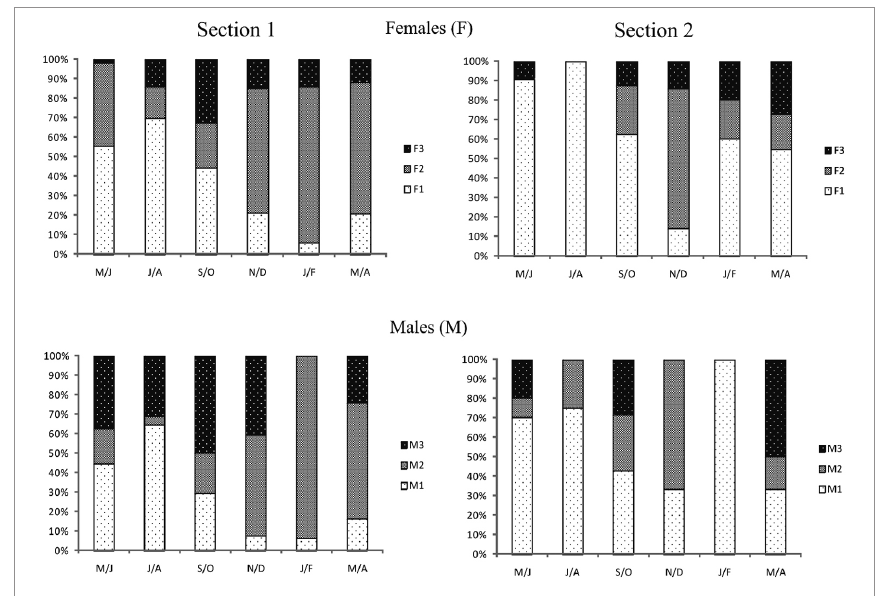
FIGURE 3 | Bimonthly distribution of stages of gonadal maturation of female and male Leporinus piau in sections 1 and 2 of the São Francisco River (SFR) basin from May 2015 to April 2016.